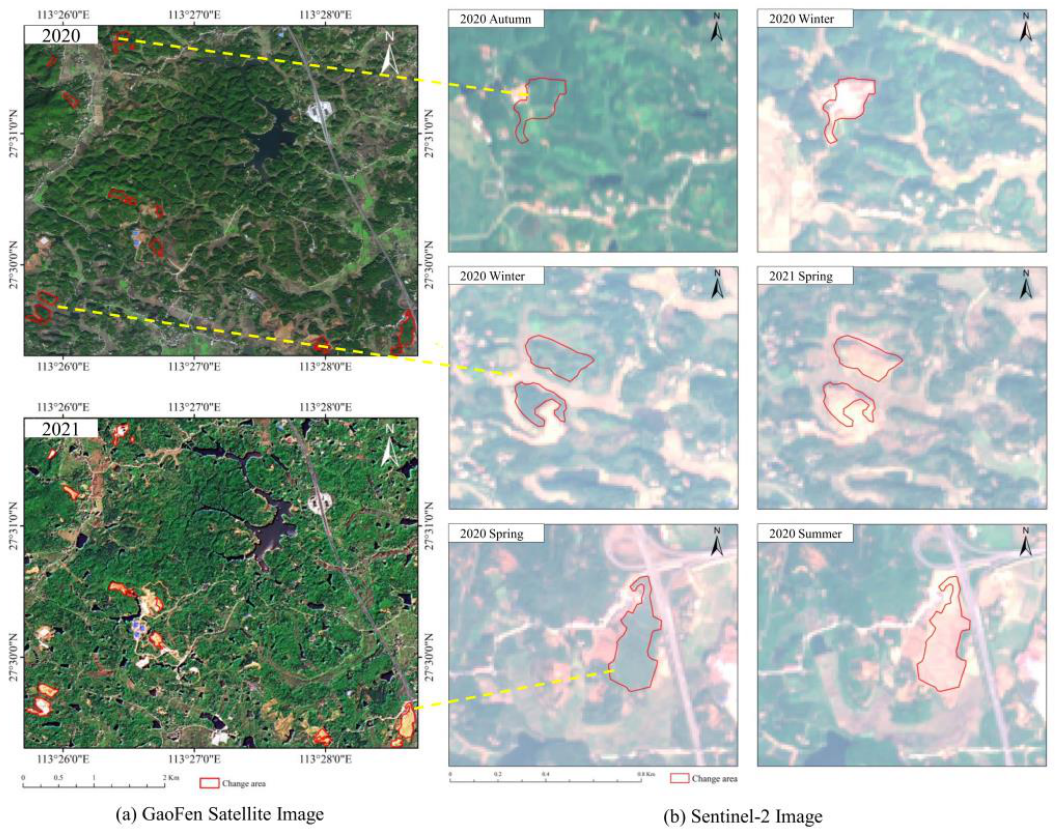
Figure 13. ( a ) GaoFen satellite images and detection results; ( b ) Sentinel-2 images and detection results.